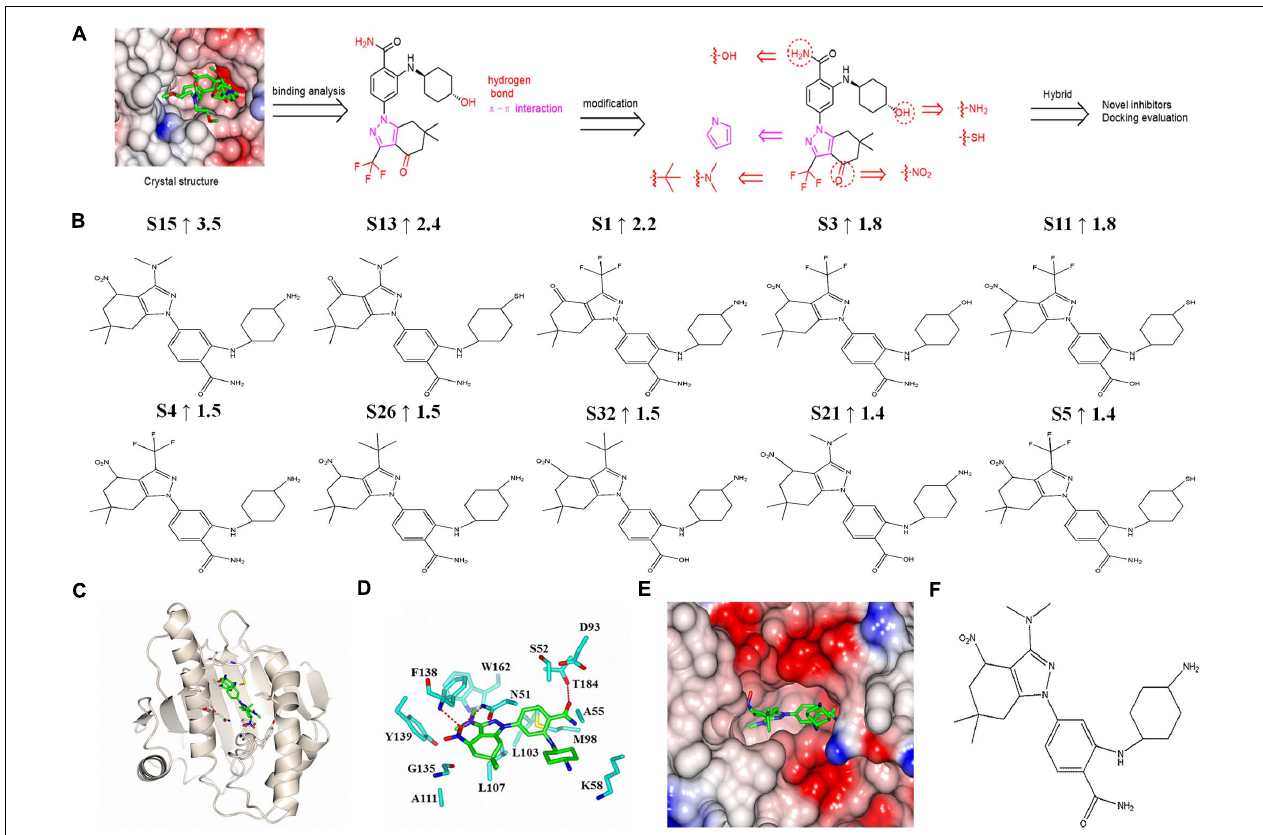
FIGURE 6 | Design and molecular docking evaluation results of new SNX-2112 derivatives. (A) Design of new SNX-2112 derivatives based on complex crystal structure and molecular interaction analysis of Hsp90 N -SNX-2112. (B) Top 10 optimal new SNX-2112 derivatives with high total score increment evaluated by molecular docking using software SYBYL-X 2.0. (C) Overall fold of complex crystal of Hsp90 N -S15. Hsp90 N and S15 are shown as cartoon and stick, respectively. (D) Molecular interaction between Hsp90 N and S15. The carbon, nitrogen, and oxygen atoms of S15 are colored in green, blue, and red, respectively. In addition, the carbon, nitrogen, oxygen, and sulfur atoms of Hsp90 N residues are shown in cyan, blue, red, and yellow, respectively. The hydrogen bonds are represented as red dashed lines. (E) Connolly surface of ATP-binding site of S15 in Hsp90 N . (F) Molecular structure of